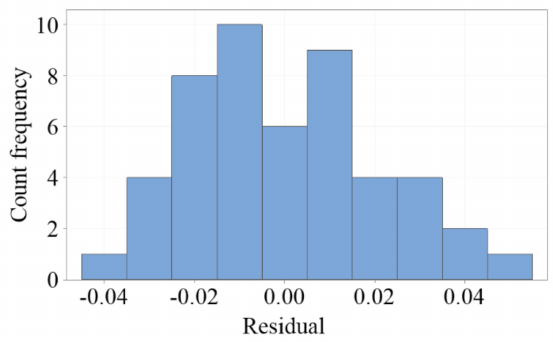
Figure 10. Histogram of the residuals, which are almost normally distributed.